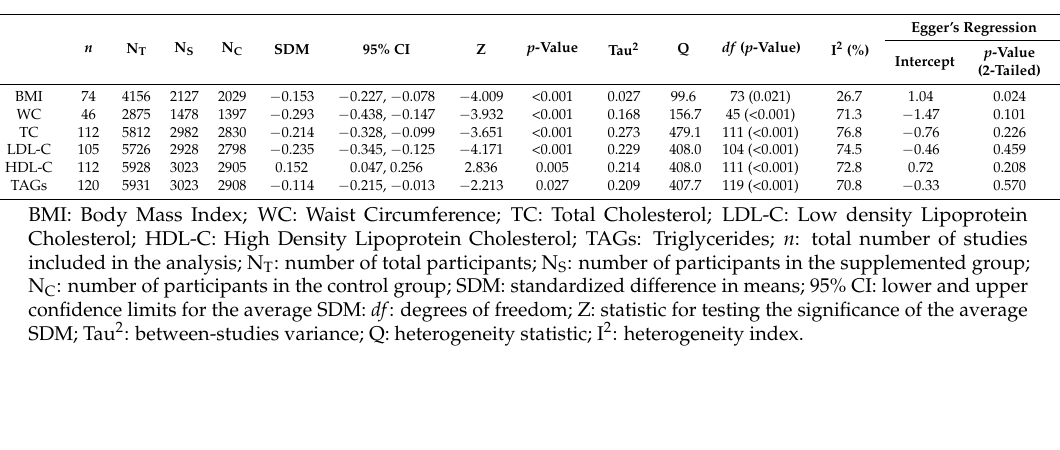
Table 2. Overall changes (SDM), heterogeneity and publication bias analyses for the impact of flavanol-containing products on BMI, WC and blood lipids levels.